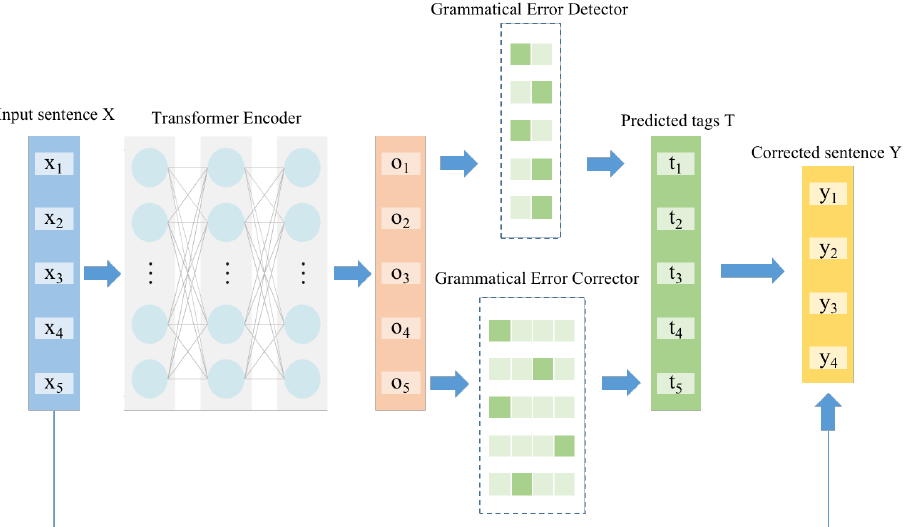
Figure 1. An overview of our